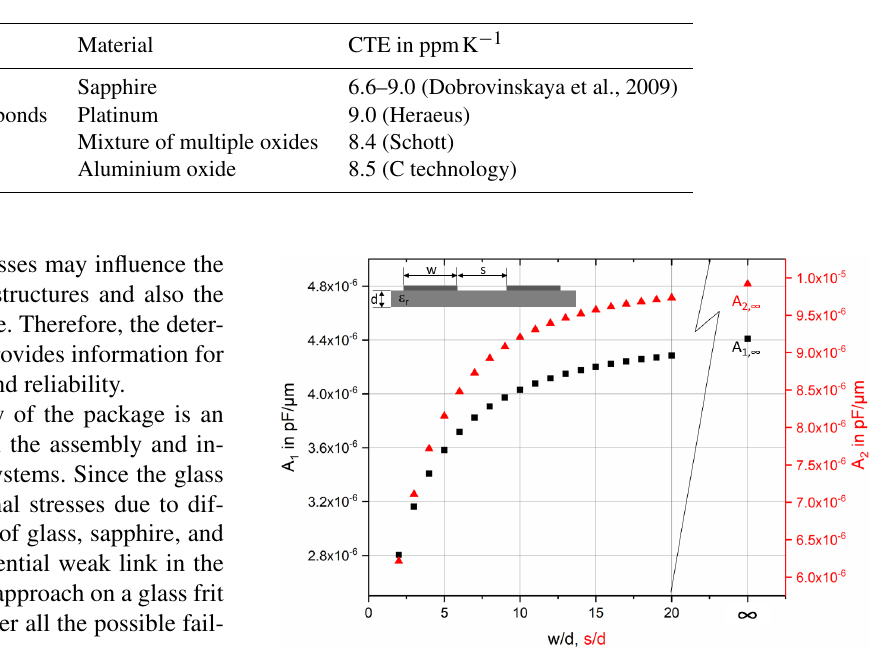
Table 4. Coefficient of the thermal expansion of the materials used according to the literature and the manufacturer’s specifications.